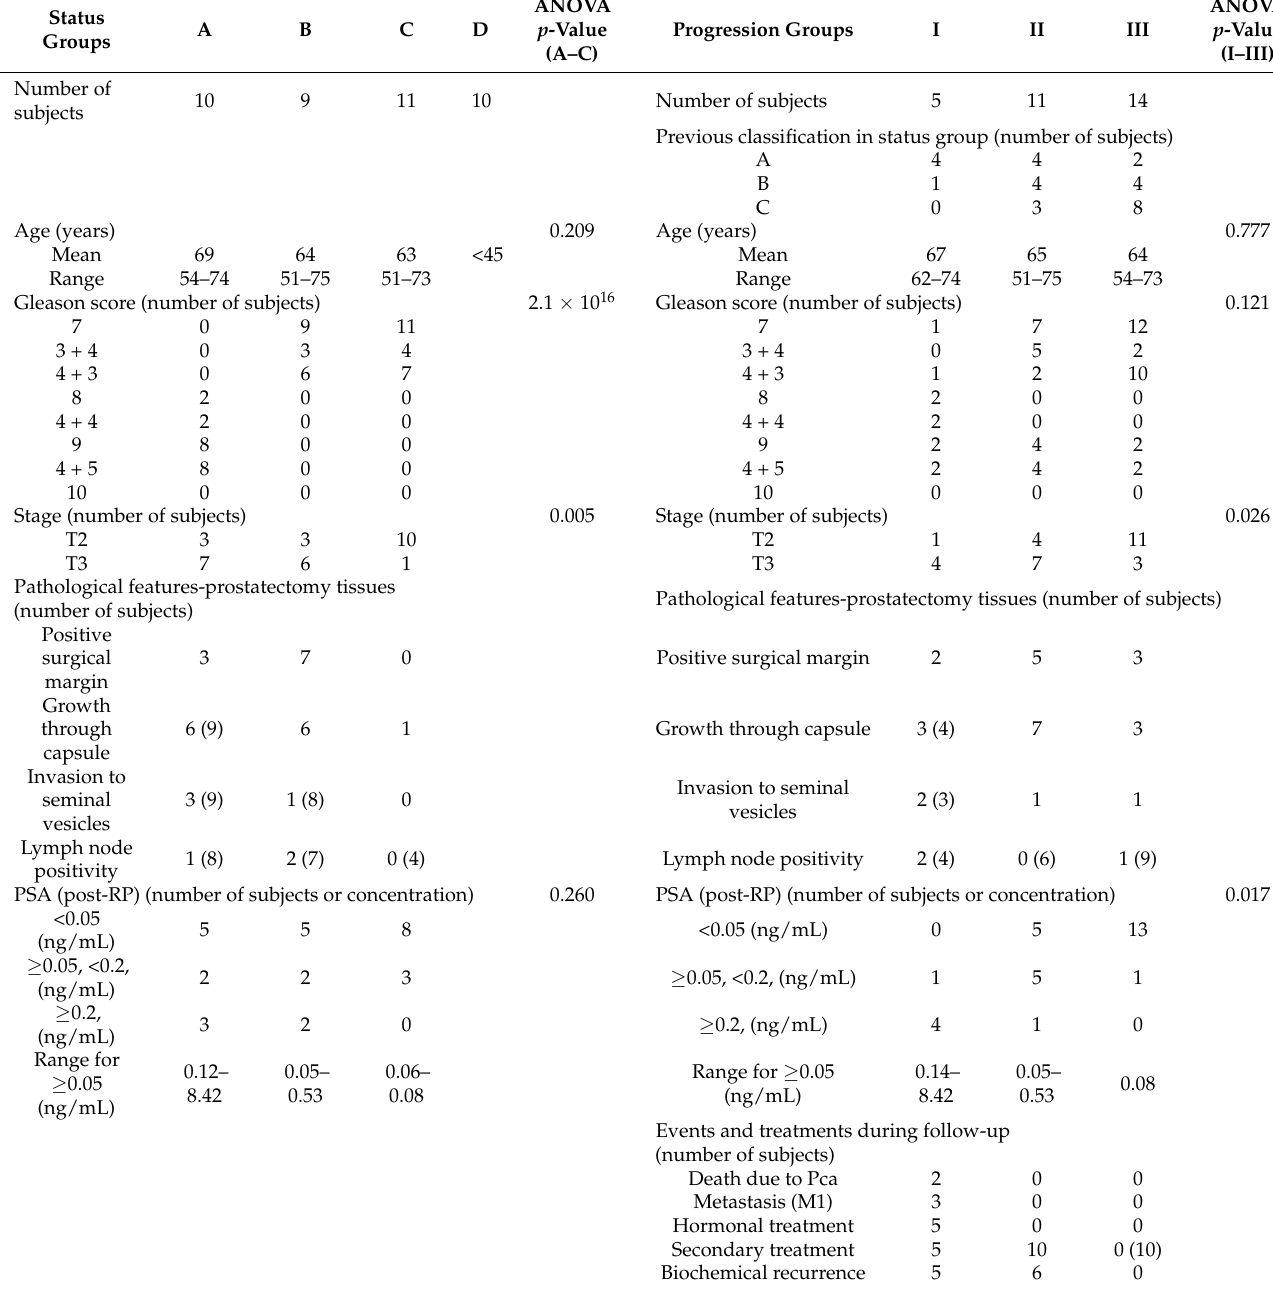
Table 1. Clinical characteristics of groups in the main study. Data of prostate cancer patients in the status Groups A–C or healthy technical controls, D, or the same patients classified into prostate cancer progression Groups I–III after 4–7 years follow-up. Numbers in parenthesis denote the subject number for whom the information was available—in the absence of parenthesis, the information was available for all patients. After prostatectomy (post-RP), prostate-specific antigen